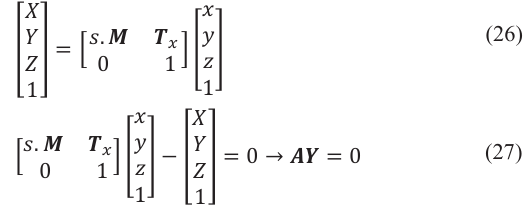
Table 1. Statistics of the object point standard deviations.